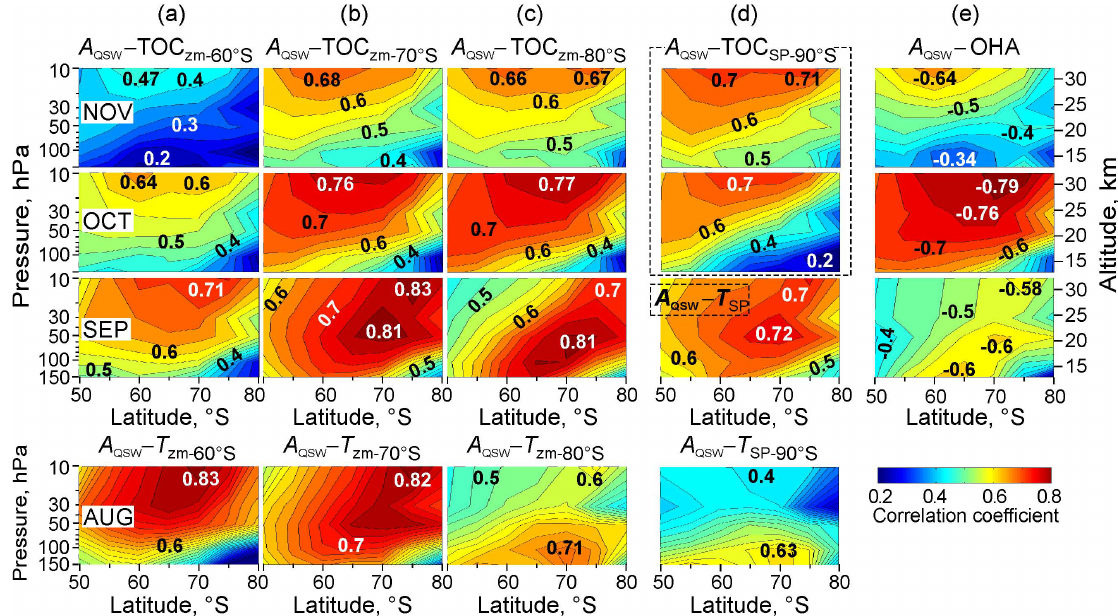
Fig. 4. Latitude-altitude distributions of the correlations between the QSW amplitude, A QSW , in August and (a – d) zonal mean stratospheric temperature, T zm , in August (AUG; T SP on d ), zonal mean total ozone, TOC zm , in September (SEP), October (OCT) and November (NOV) at the latitudes 60 ◦ –90 ◦ S (TOC SP on d in OCT and NOV) and (e) ozone hole area, OHA (note the opposite sign of the correlation